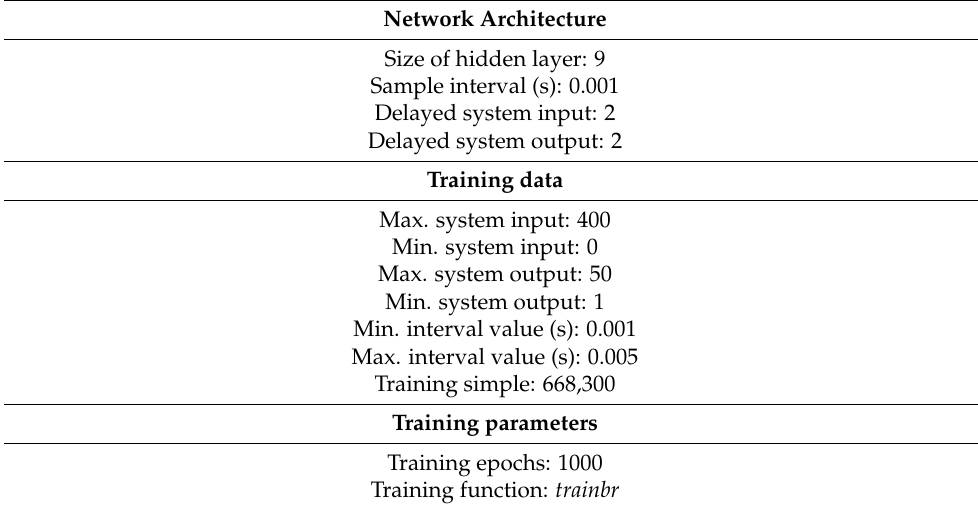
Table 5. Design parameters for